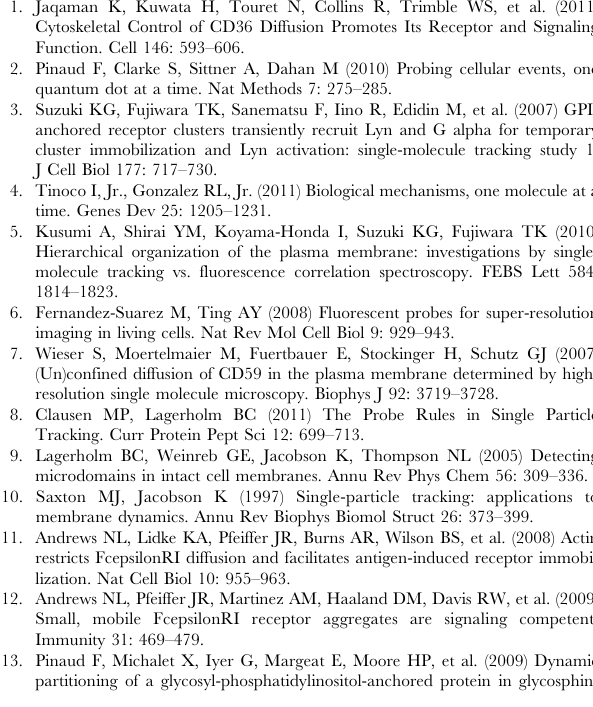
Figure S12 Fitted diffusion coefficients, D 5 , for biotin- cap-DPPE for each sAv-QD conjugate in each image channel for the MC-SPT example in Figure 6. The diffusion coefficient, D 5 , was determined by calculating the MSD curve for each trajectory that were longer than 20 steps, and by curve fitting the initial five points, t , n t , 5 t, of each trajectory, as is described in the Methods section. The entire distribution of the fitted values of D 5 are shown for all trajectories that were labeled with a) sAv-QD565 (N= 289), b) sAv-QD605 (N = 142), c) sAv-QD655 (N= 162), and d) sAv-QD705 (N= 131). The mean diffusion coefficient, , D 5 . , ( 6 SEM) was for a) sAv- Table S1 Product specifications of investigated QDs. The reported molar extinction coefficients are those given by the manufacturer. Table S2 Quantification of mean intensity, I QDon , and fractional intermittency times, F QDon , of single QDs with 500 LP Emission Filter Microscope Configuration. Table S3 Hydrodynamic Radii of QDs. Table S4 Quantification of fluorescence intensities, I QDon , and fractional intermittency times, F QDon , of